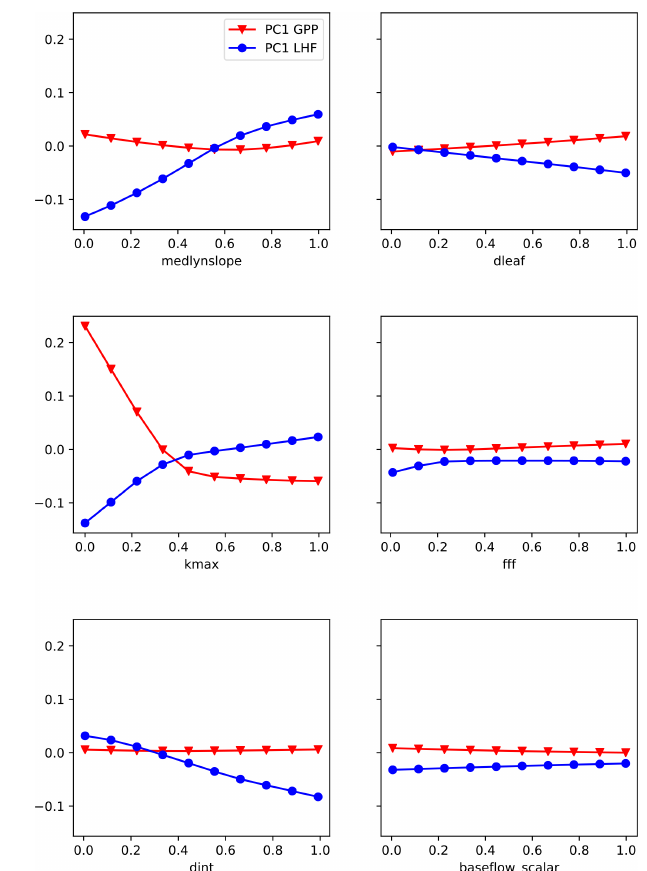
Figure 8. Partial dependence plots of PC1 for GPP (red) and LHF (blue) from the neural network emulators. Circles and triangles de- note the fixed values used for predictions with each parameter. The x axis shows the parameter scaling values, and the y axis shows the average prediction of